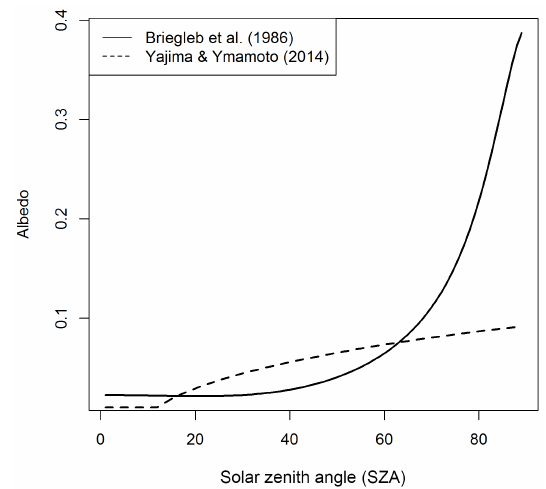
Figure 3. Variation of albedo ( α SW ) with solar zenith angle (SZA = (cid:56) zen 180 /π , degrees) for options 2 and 3 (Eq. 13). For option 3, settings of RH x = 80% and U 10 = 6ms − 1 were